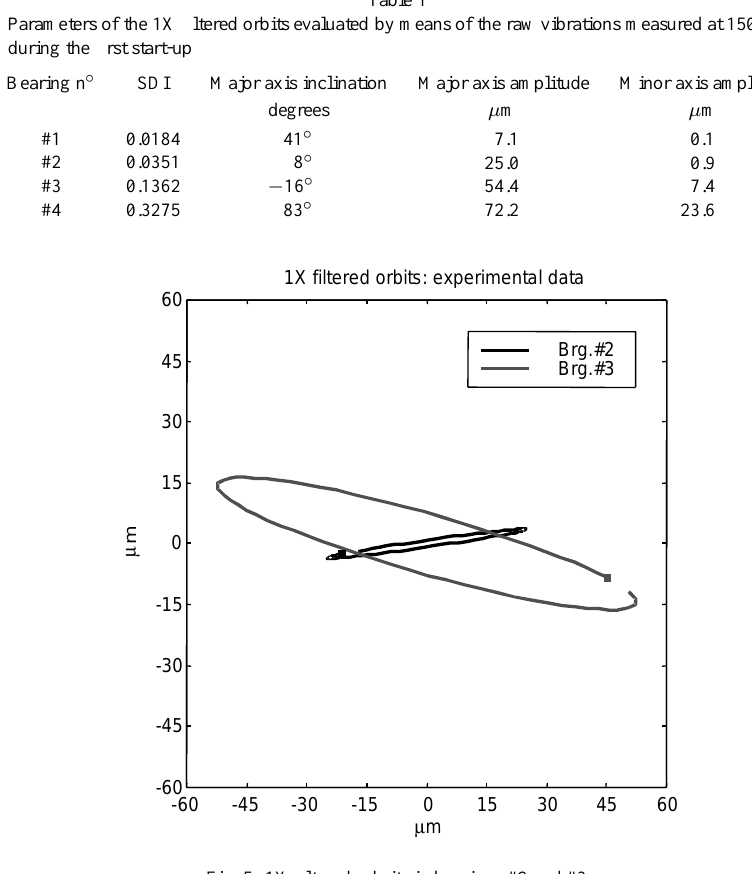
Fig. 5. 1X filtered orbrits in bearings #2 and